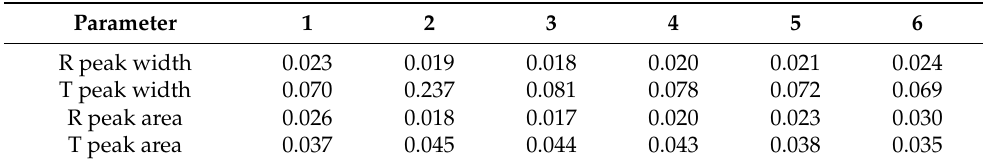
Table 2. Numerical results of applying the proposed approach for distinguishing R waves from large T waves on the ECG signal (based on the waveform acquired using the